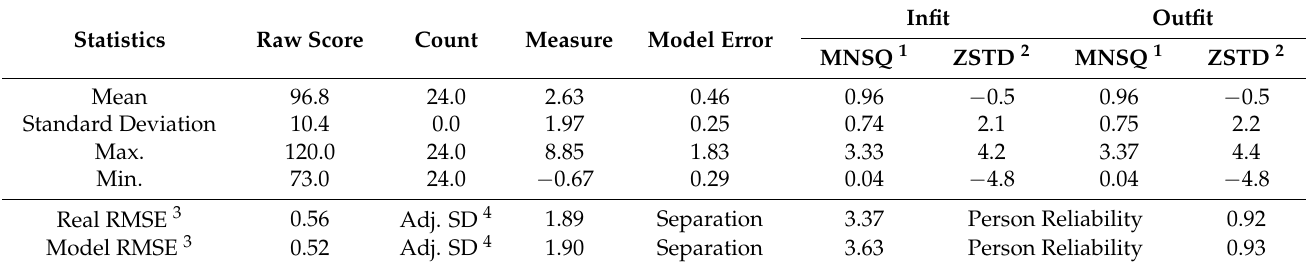
Table 12. Statistical summary of individuals (transformational